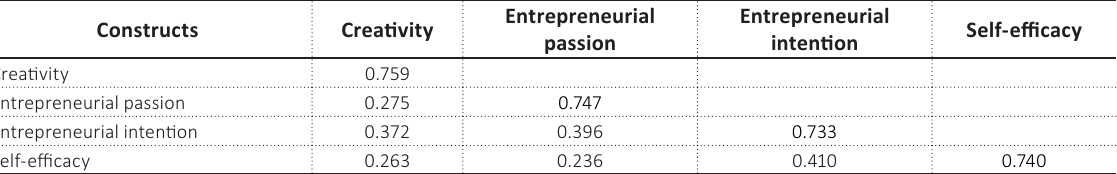
Table 4. Discriminant